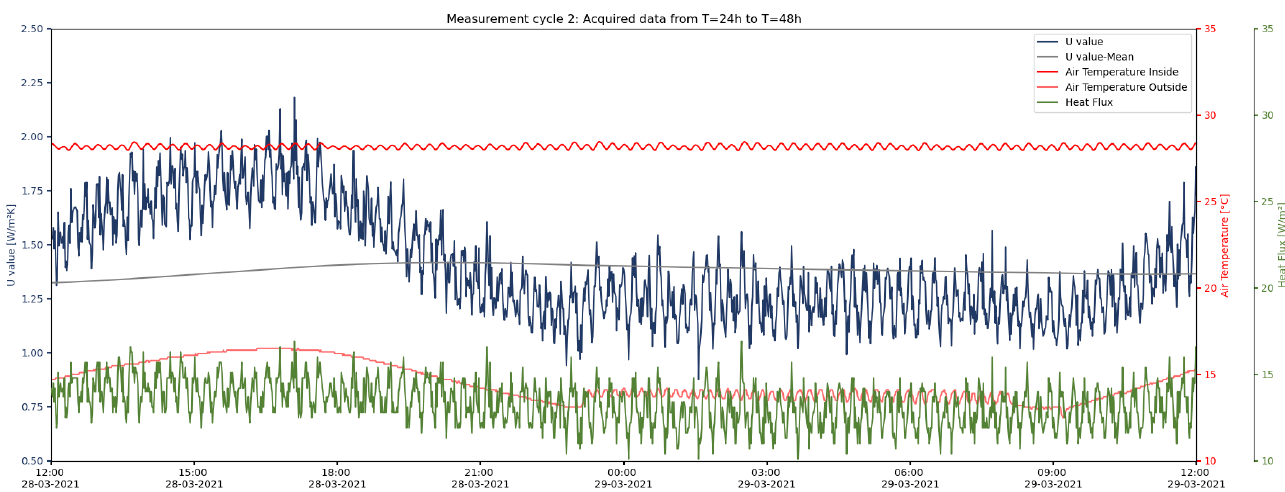
Figure 9. Results of the heat flux measurement cycle 2 from T = 24 h to T = 48 h. Table 5. Collected data and resulting thermal properties for single time steps.